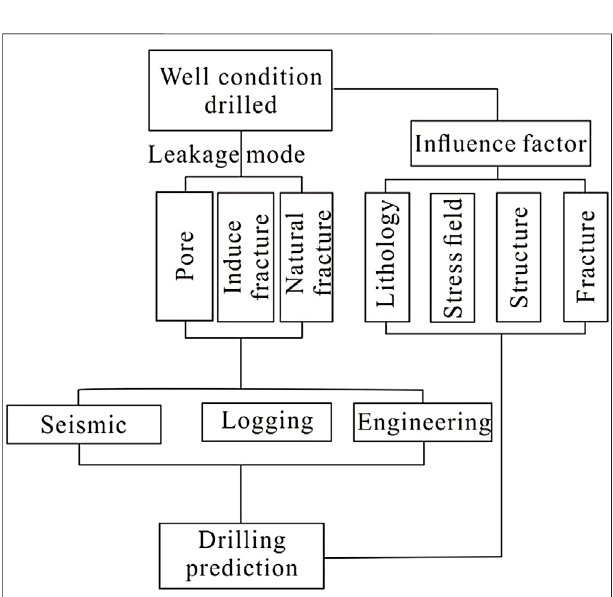
FIGURE 6 | Technical roadmap of strike-slip faults and fractures and their in fl uence on drilling